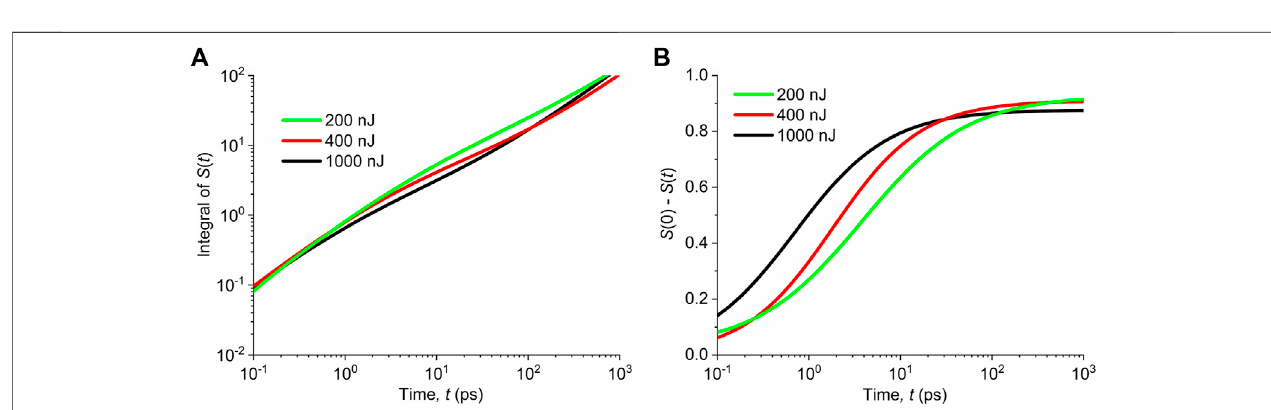
FIGURE7|(A) Calculateddependencesof (cid:1) t d τ S ( τ ) (tripletpopulationgeneratedbytheinter-systemcrossing). (B) Calculateddependencesof S ( 0 ) − S ( t ) (triplet 0 population generated by the singlet bi-molecular annihilation) from the fi tted singlet population S ( t ) . Different intensities of pump fl uences are shown in the legend. Initial singlet population is normalized to unity.